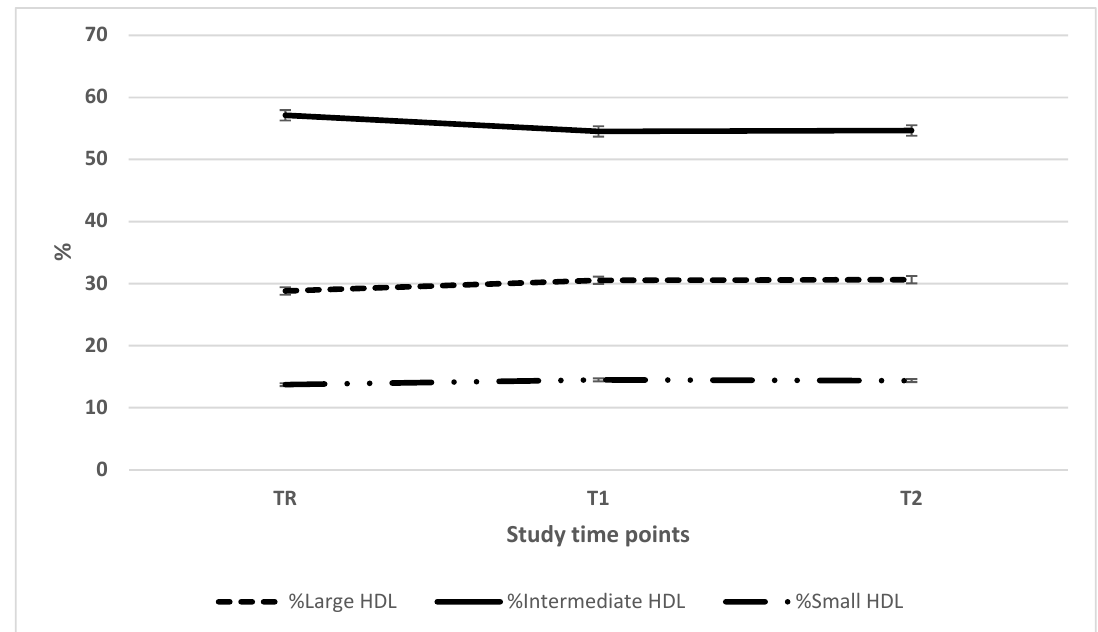
Figure 2. HDL particle size distributions. The percentage of HDL particle size (large, intermediate and small) distributions during the study period. Abbreviations: HDL: high-density lipoprotein; TR: during Ramadan; T1: one month post-Ramadan; T2: two months post-Ramadan. There is a significant di ff erence for % intermediate HDL between TR and T1 and between TR and T2 at p < 0.5 level. Nutrients 2019 , 11 , x FOR PEER REVIEW